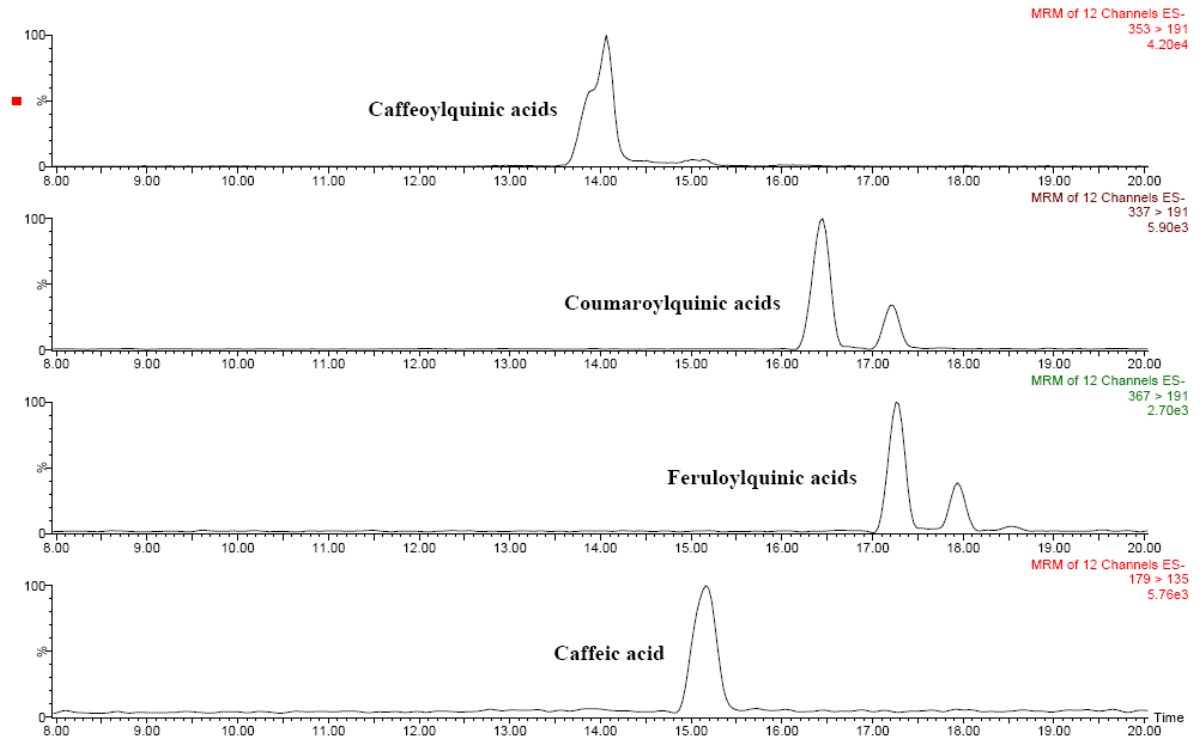
Figure 4. HPLC-ESI-MS/MS chromatograms of main phenolic acids in red Solanum indicum